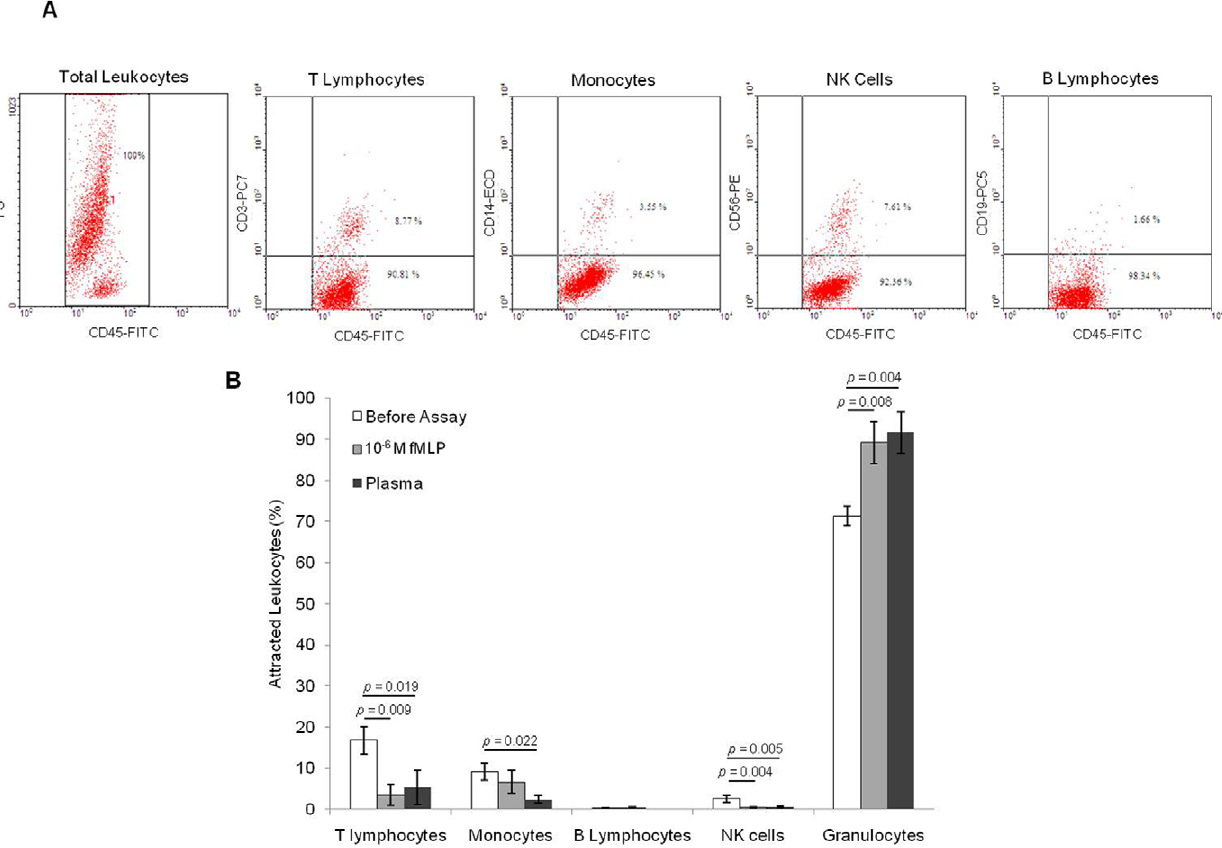
Figure 3. Specificity of CBFCA. CBFCA involves the determination of the leukocyte phenotype using conjugated specific antibodies and flow cytometry. A) Representative dot-plots showing the dual parameters used for the flow cytometric analysis: CD45 + for total leukocytes, CD45 + CD3 + for T-lymphocytes, CD45 + CD14 + for monocytes, CD45 + CD56 + for NK cells and CD45 + CD19 + for B lymphocytes. B) Specific leukocyte chemotactic activity of 10 2 6 M fMLP and plasma. Leukocyte subset proportions were significantly different before and after the assay. Data shown are means 6 SD of five independent assays in triplicate. Significance was determined by ANOVA and Games-Howell test.